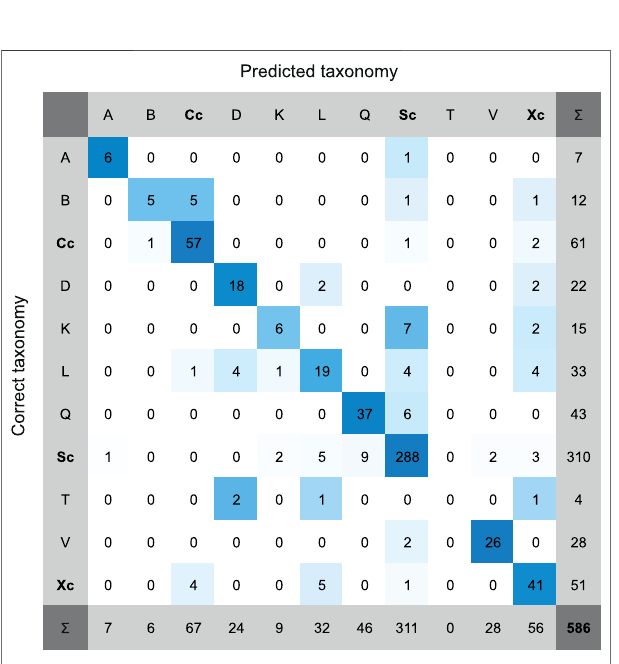
FIGURE 2 | Confusion matrix plot of the results of the NN taxonomic classi fi cation of simulated LSST observations. The correct taxonomic types are organized in rows and predicted types in columns. The rightmost column is a row sum, and the bottom row is a column sum of the asteroids. For example, for class D there are 22 asteroids of which 18are correctly classi fi ed as D class, and 2 incorrectly as X-complex. In total, 586 asteroids are classi fi ed. The blue-to-white color of the cell indicates the share of the asteroids from that row having the predicted type of that column. A perfect classi fi er should have deep blue throughout the diagonal, and white elsewhere.